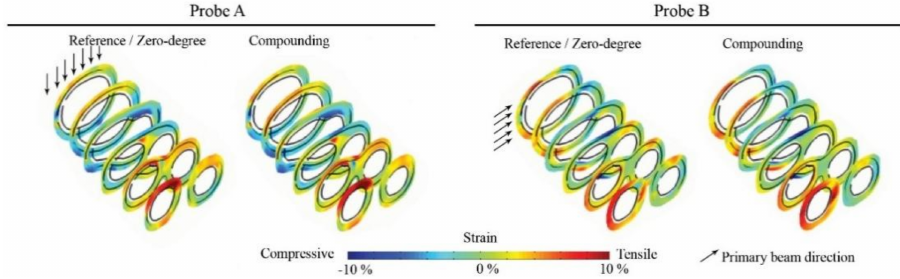
Figure 8. Longitudinal strain estimates originating from both probes at peak systolic